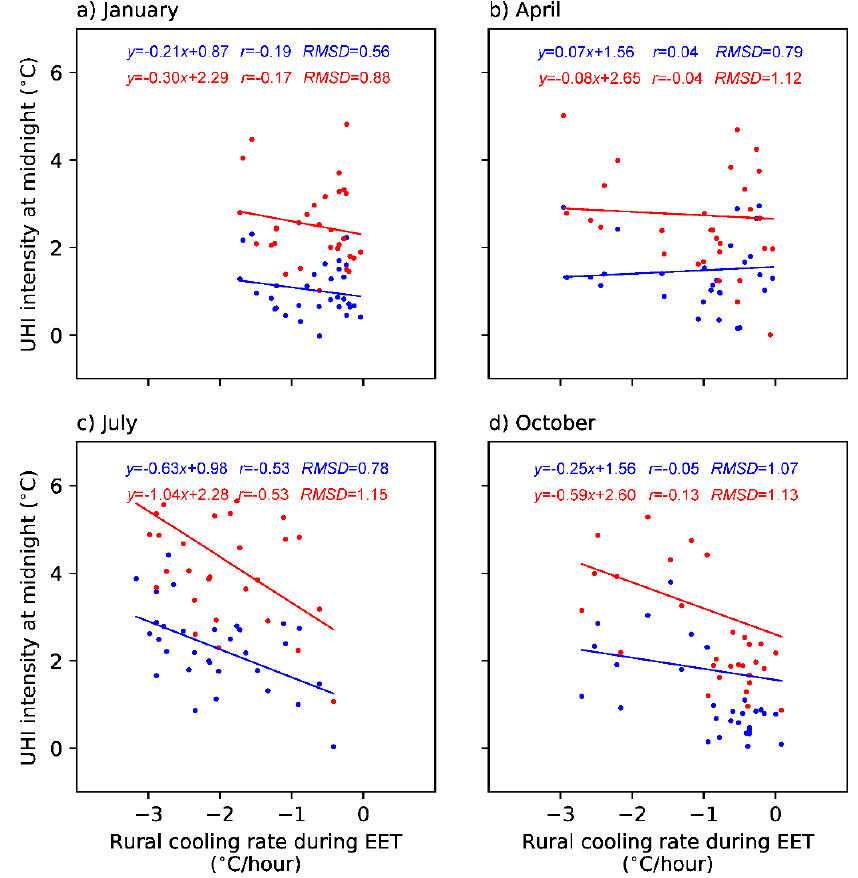
Figure 11. Same as Figure 7, but for ( a ) January, ( b ) April, ( c ) July, and ( d ) October.